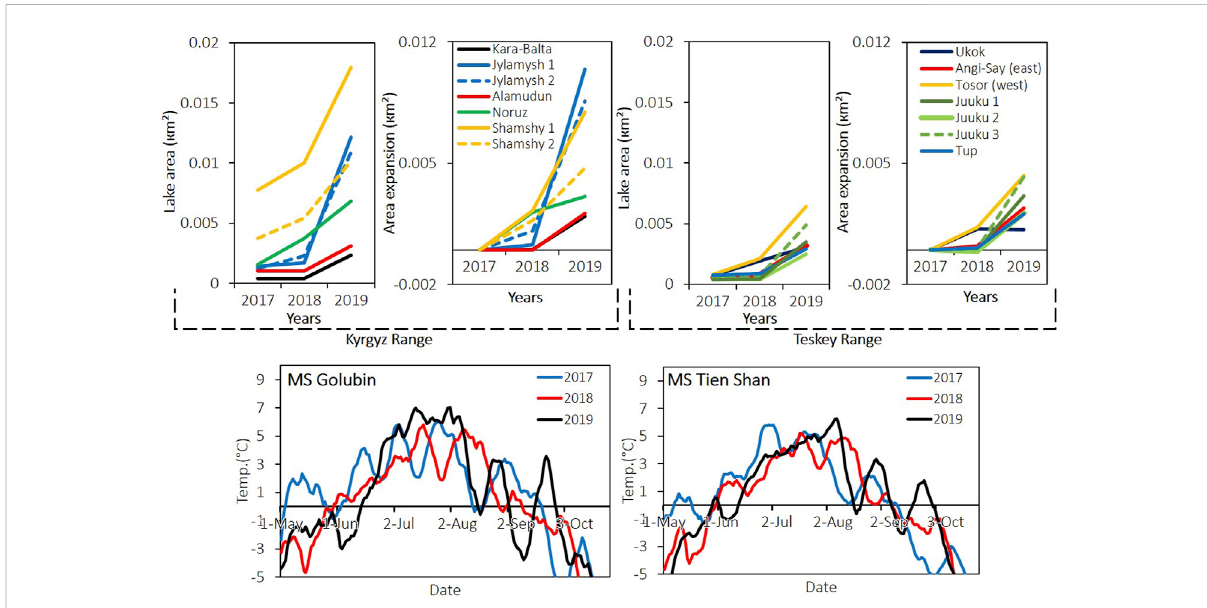
FIGURE 5 The fourteen glacial lakes ’ largest area changes, as well as their rate of expansion, from 2017 to 2019. In Figures 3A,B, their locations are depicted. The below panels show an 11-day running mean of summer temperature (May – October) anomaly in 2017 – 2019 at the Golubin (Kyrgyz Range) and Tien Shan (Teskey Range) meteorological stations (for locations, see Figure 1).